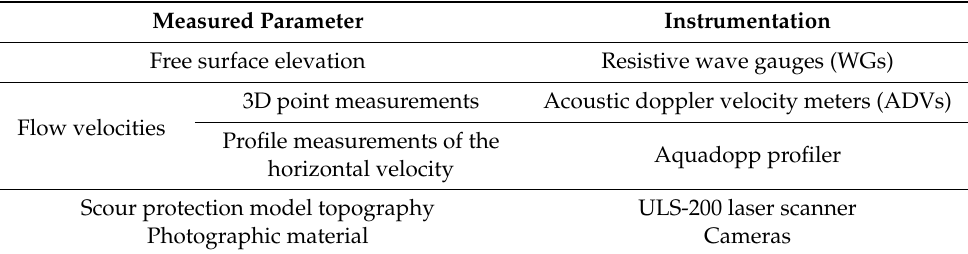
Table 1. Measured parameters and instrumentation.